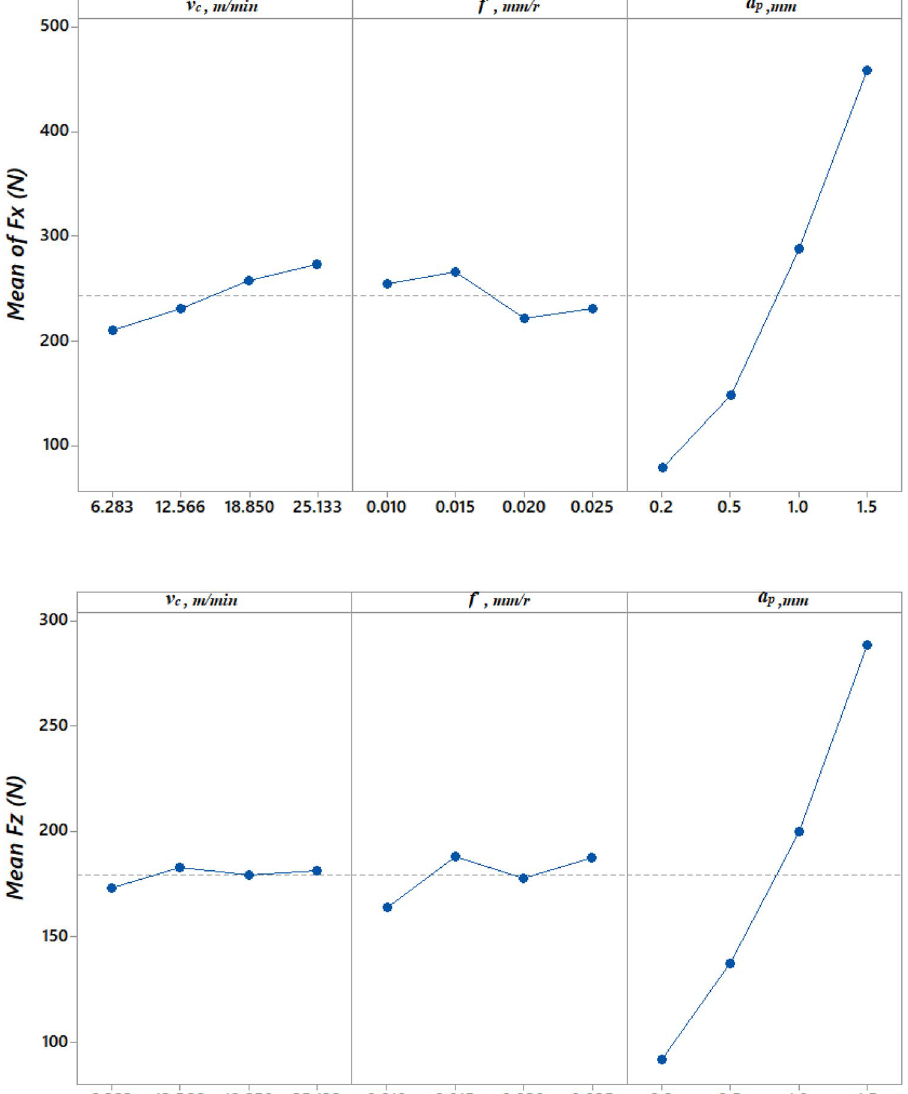
Fig. 2 main effect plot of F x for